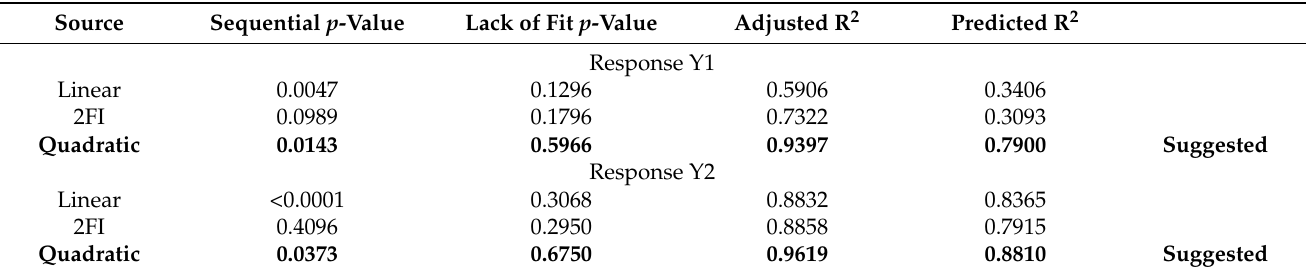
Table 7. Regression analysis summary for different models fitting